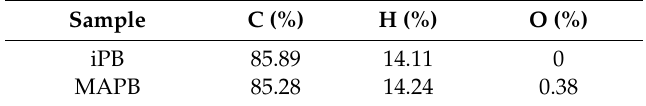
Table 2. Elemental analysis of iPB and maleic anhydride grafted polybutene